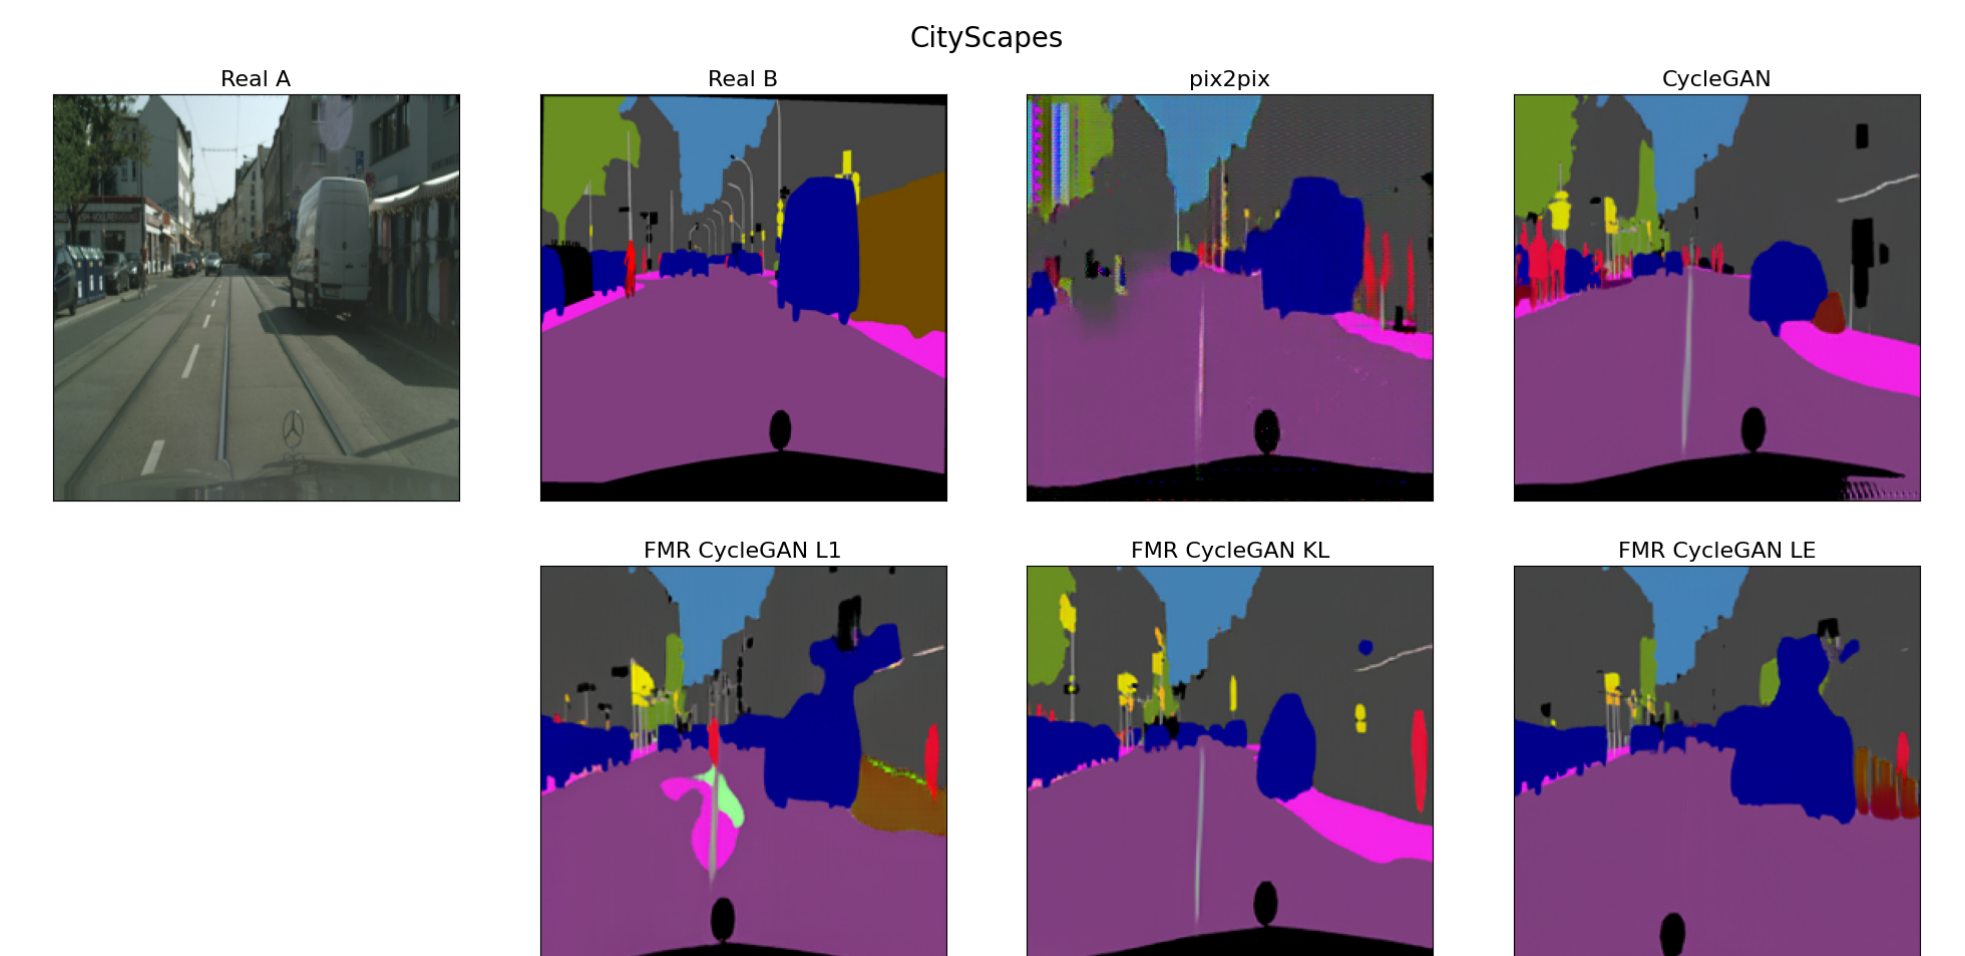
Figure 6. Visual comparison on the first example of paired images from the CityScapes photo2labels task (denoted as “Real A”, belonging to the source or “left” domain, and “Real B”, belonging to the target or “right” domain). The Proposed FMR CycleGAN with various ground distances (L1 corresponding to (8), KL corresponding to (10), and LE corresponding to (12)) was compared against the baseline CycleGAN and pix2pix